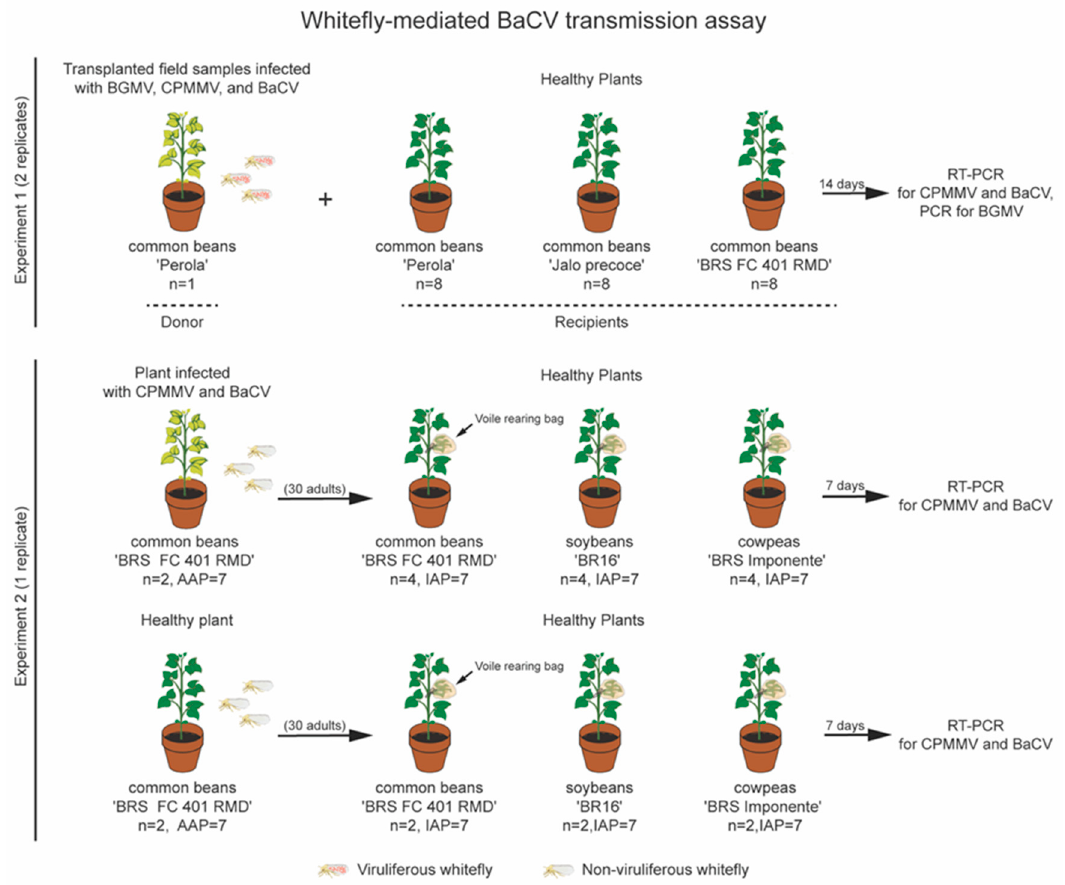
Figure 3. Whitefly ( Bemisia tabaci Middle East-Asia Minor 1 (MEAM1)) mediated transmission of BaCV. Outline of experimental procedures: In experiment 1, a common bean plant with whitefly colonies from the field was used as an inoculum source for BaCV (BGMV and CPMMV) transmission to bean plants ‘Jalo’, ‘P é rola’ and ‘BRS FC 401 RMD’. After 14 days, samples were collected, and BaCV (CPMMV and BGMV) transmission confirmed by RT-PCR and PCR. In experiment 2, whiteflies were exposed to BaCV- (and CPMMV)-infected plants for a 7-days acquisition period. Thirty whiteflies were transferred from the inoculum source plant to a healthy plant leaf wrapped by a voile rearing bag for a 7-days inoculation period. After seven days, samples were collected and tested by RT-PCR. The same procedure was applied to healthy plants with aviruliferous whiteflies as controls.